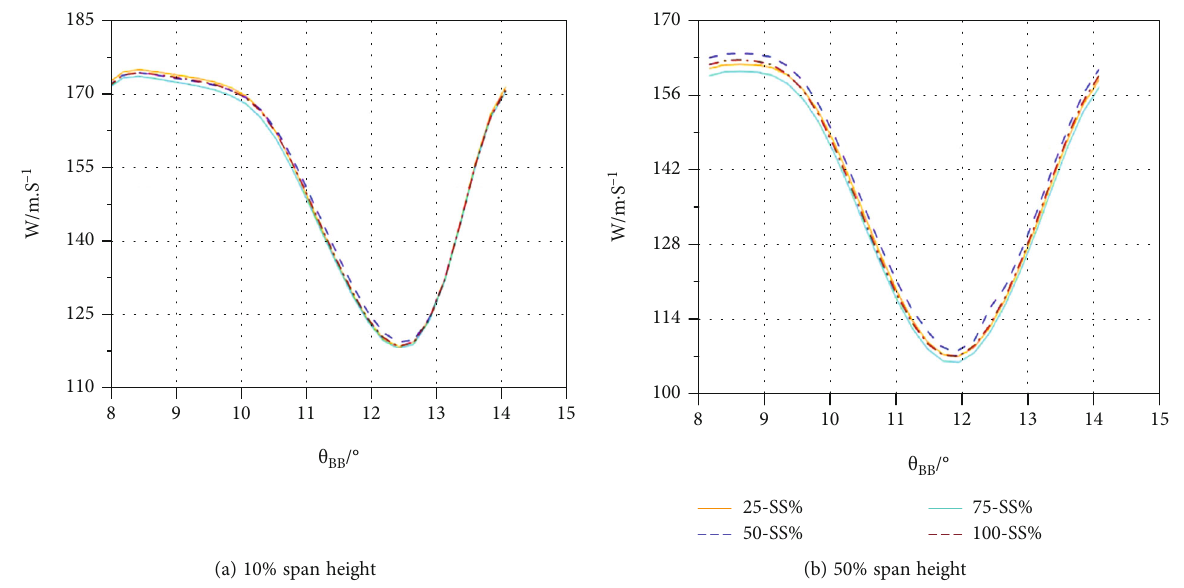
Figure 24: Relative velocity downstream of the stator for the di ff erent roughness locations at k + = 137 : 8